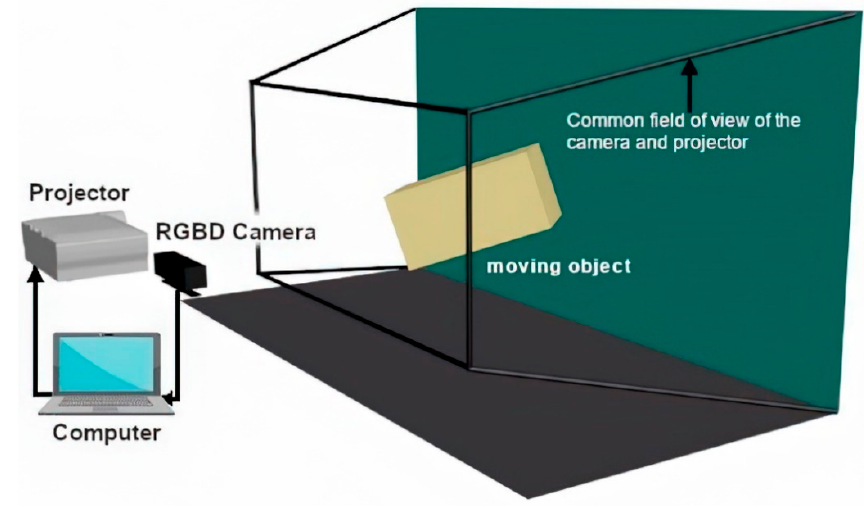
Figure 3. System layout and t he common field of camera and projector view.